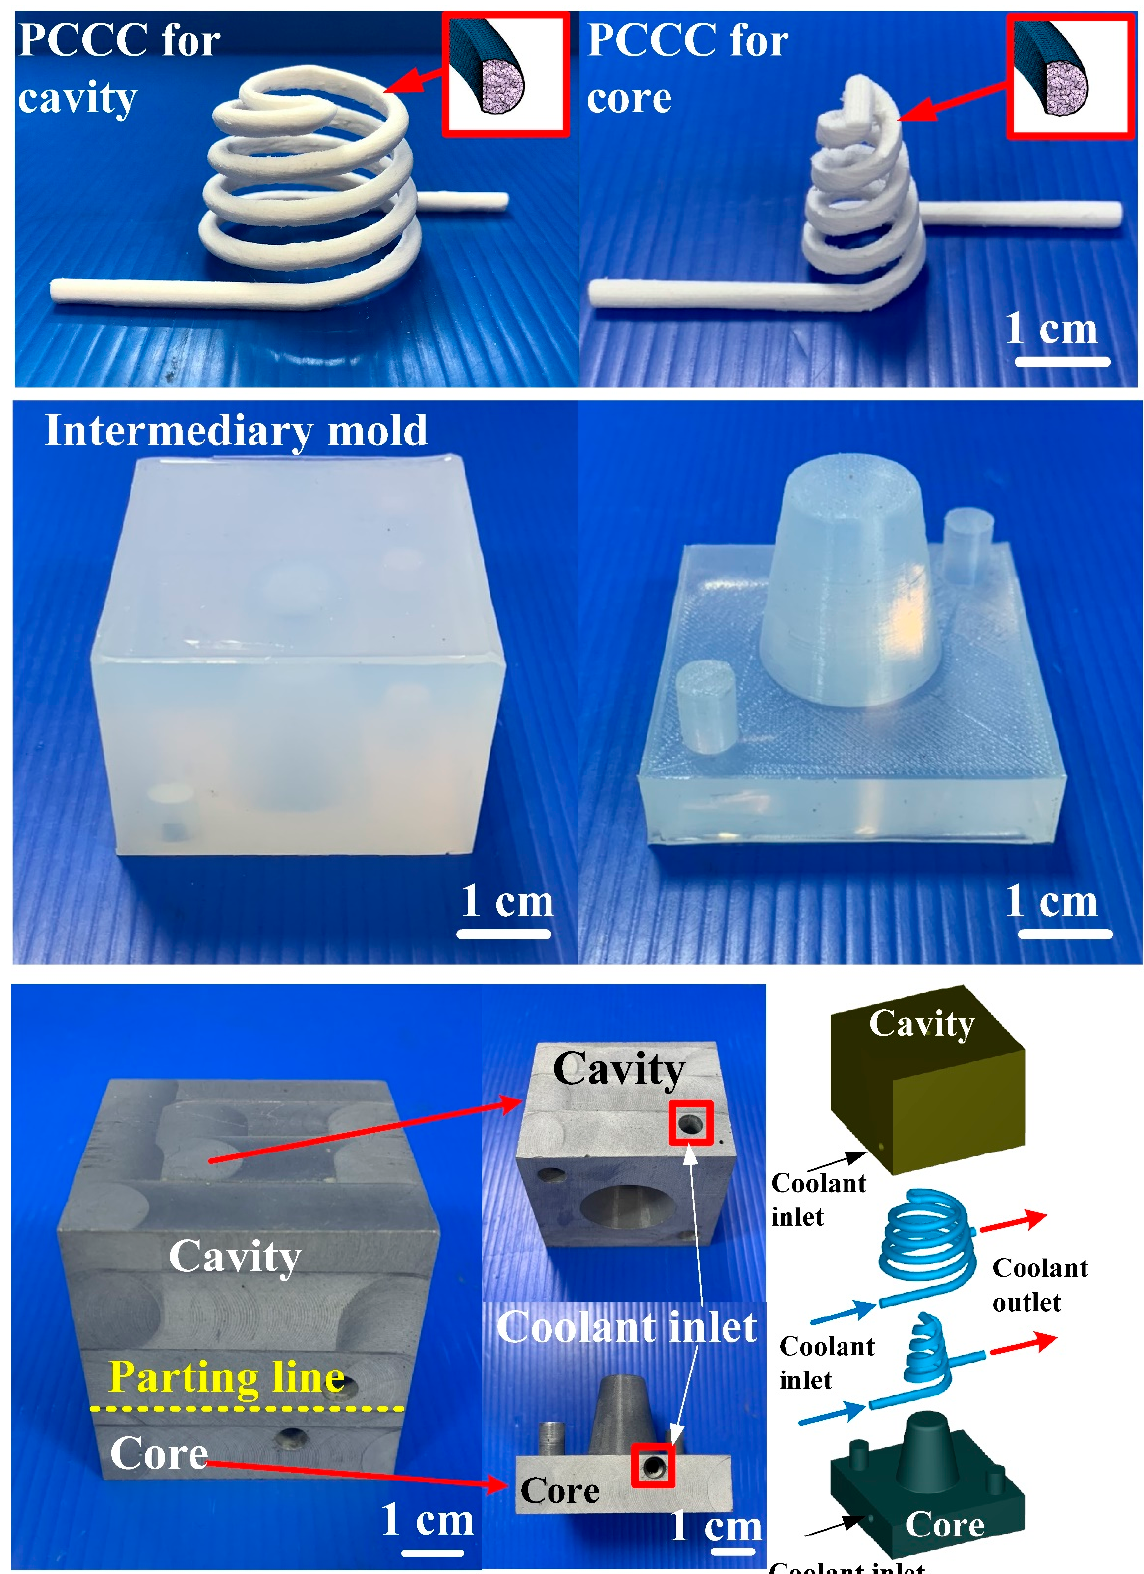
Figure 16. Injection mold fabricated with commercial material.